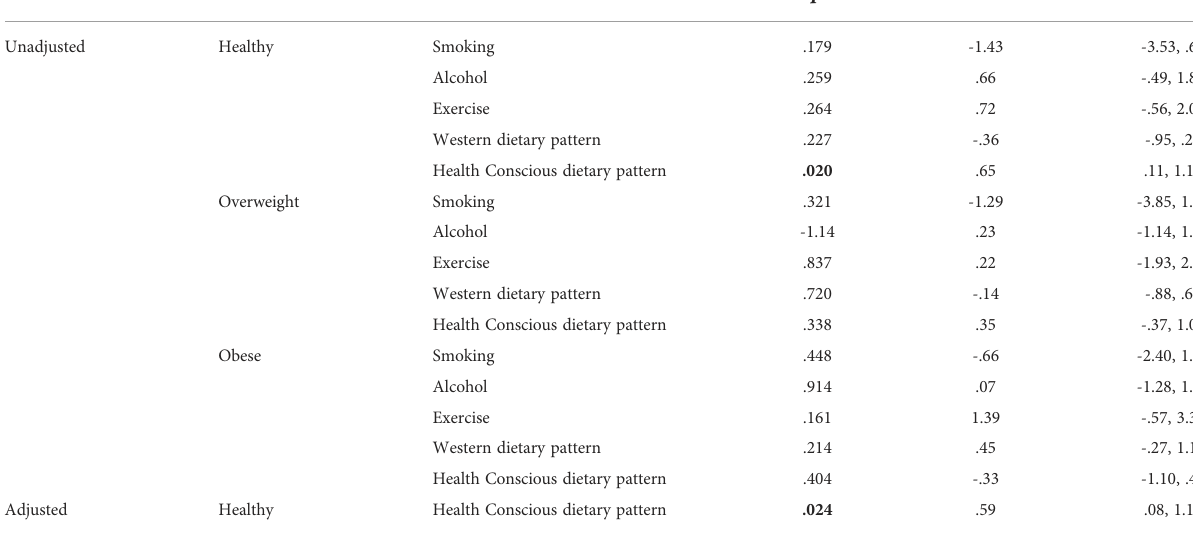
TABLE 3 Unadjusted and adjusted linear regression indicating the association between maternal prenatal health behaviours and hPL ( m g/mL) when strati fi ed by maternal BMI at booking.